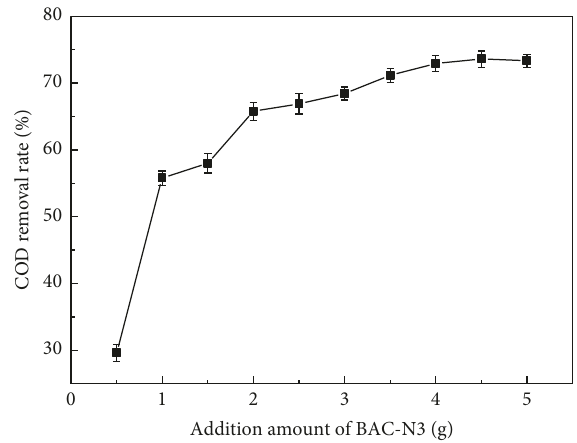
Figure 4: Effects of addition amount on the COD removal rate (the error bars indicate standard deviation of the mean of three sets of